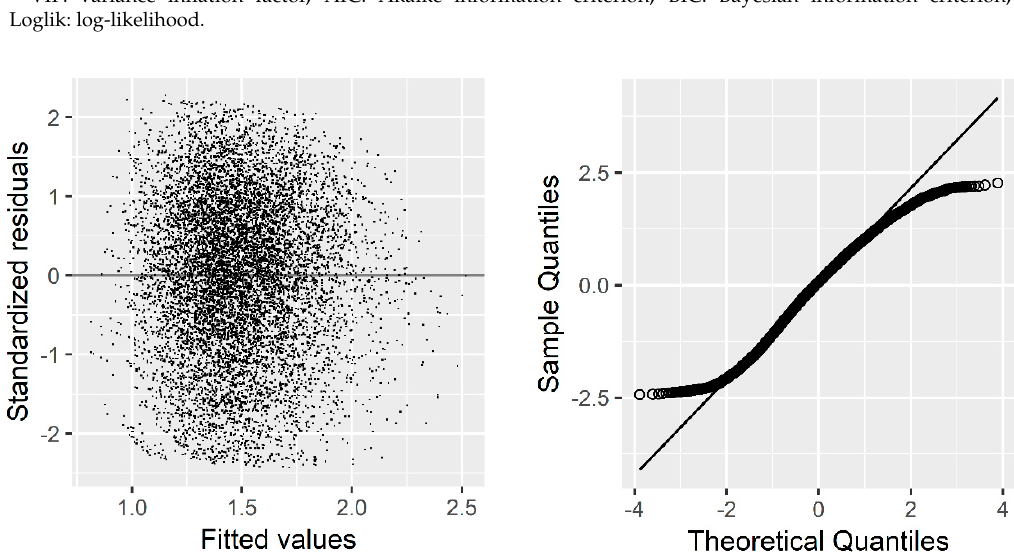
Loglik: log-likelihood.